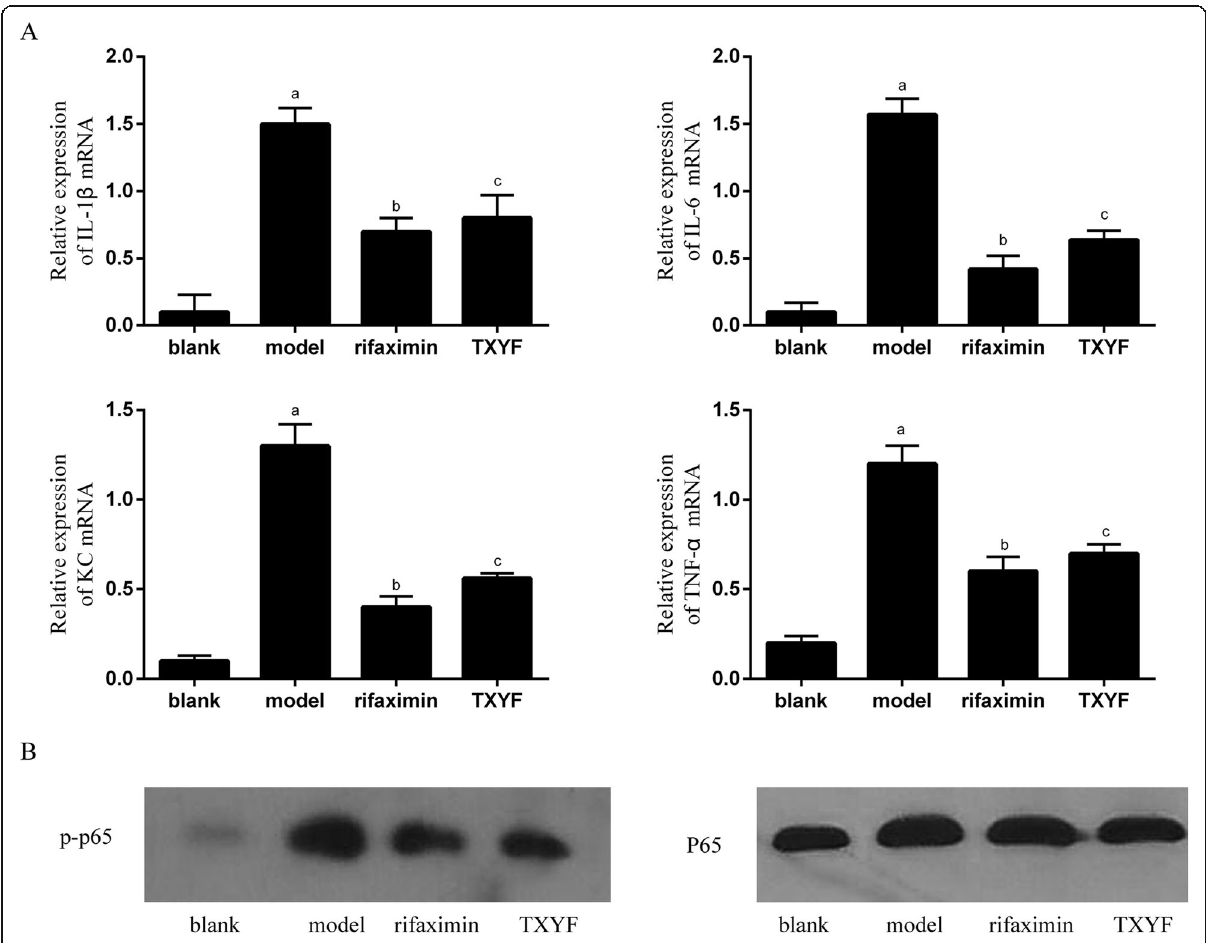
Fig. 5 TXYF inhibits the activation of NF- κ B and regulates the production of pro-inflammatory cytokines in colonic tissues of IBS-D rats. a qRT-PCR detection for IL-1 β , IL-6, TNF- α and KC in colonic tissues. b Western blot analysis for p-p65 and P65 in colonic tissues. a P < 0.05 vs the blank group. b P < 0.05 vs the model group. c P > 0.05 vs the rifaximin